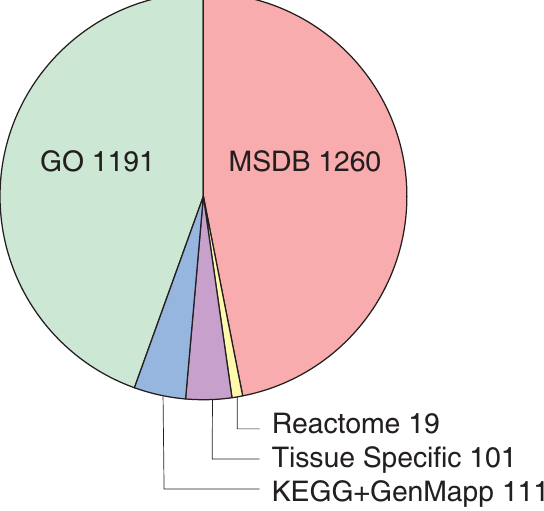
Figure 3. Pie chart indicating the origin of the gene sets. A total of 2682 gene sets were collected. The GO, KEGG, GenMapp, and Tissue specific gene sets were taken from the study by Segal et al. [10]. The Reactome pathways were downloaded from the Reactome website [23], and the MSDB gene sets were taken from the molecular signature database